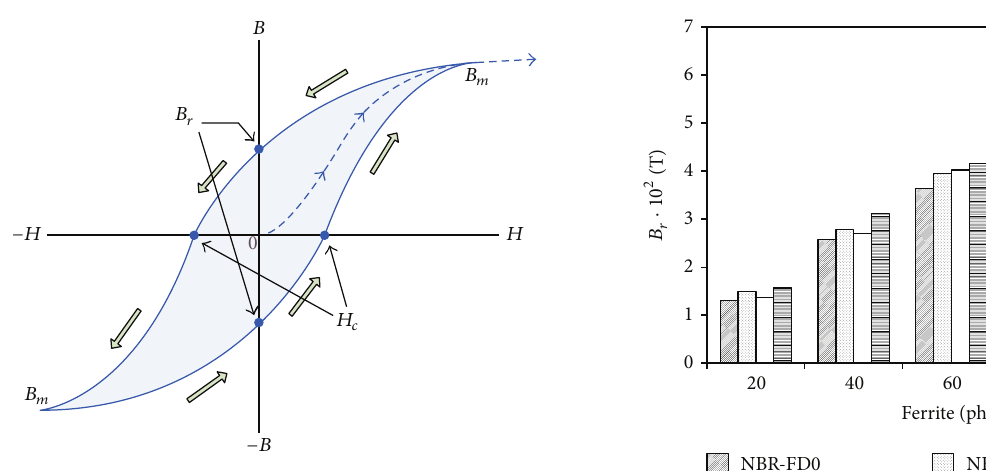
Figure 13: Magnetizing curve of magnetic materials.